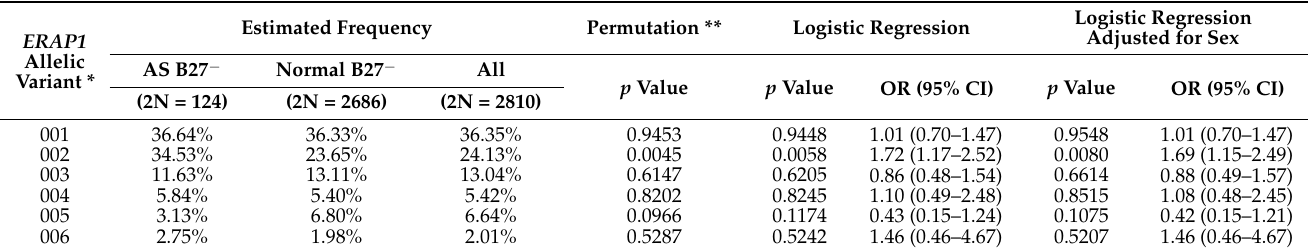
Table 3. Distributions of ERAP1 allelic variants in HLA-B27 − AS patients (AS B27 − ) and HLA-B27 − healthy controls (Normal B27 −